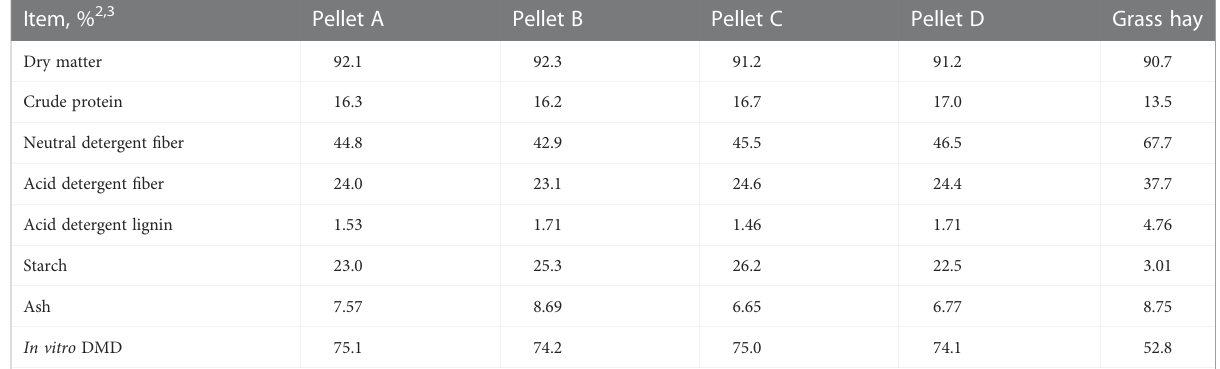
TABLE 2 Nutrient analysis of treatment pellets and grass hay 1